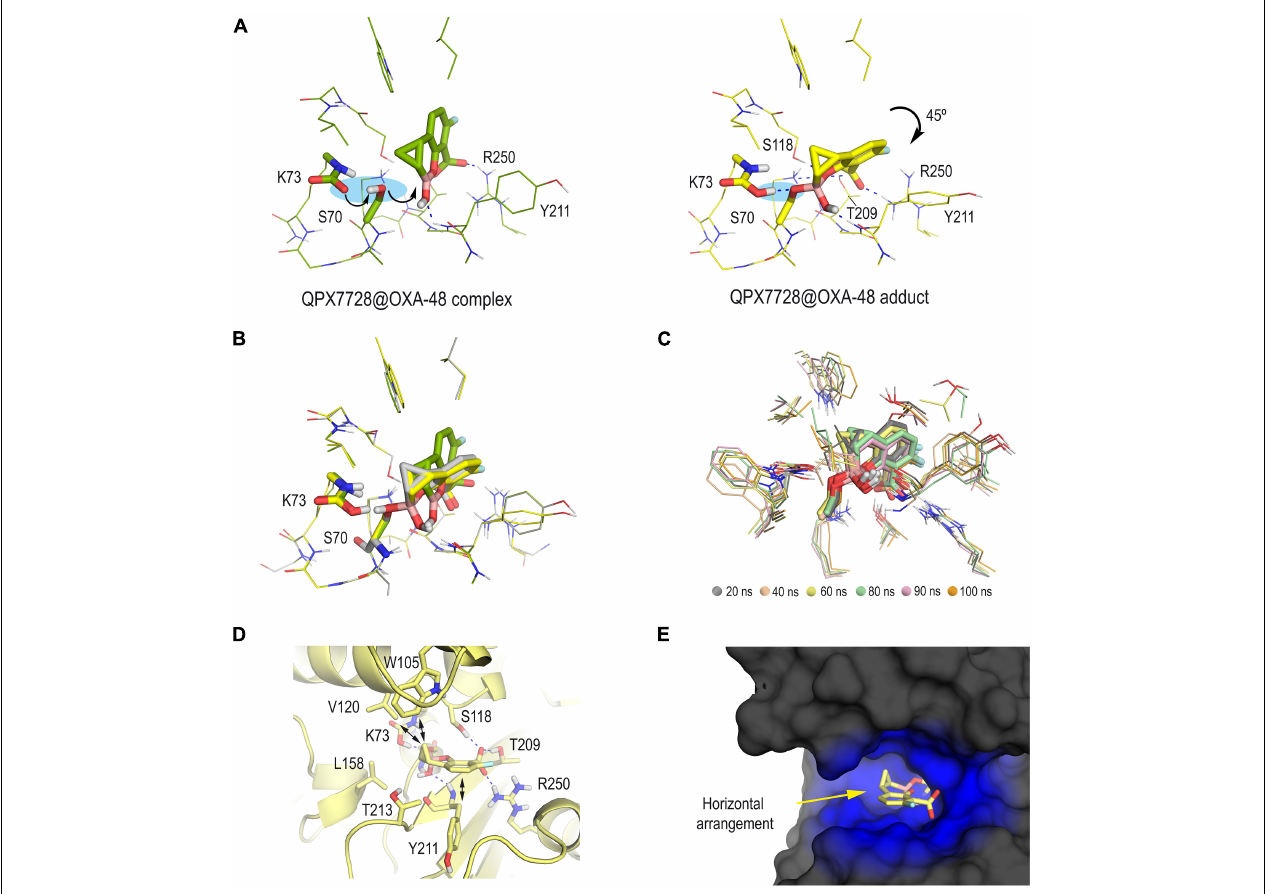
FIGURE 2 | (A) QPX7728@OXA-48 complex (green) and QPX7728@OXA-48 adduct (yellow) obtained by computational studies. Note how the formation of the enzyme adduct would involve the deprotonation of the catalytic serine by the carboxylated residue K73 followed by nucleophilic attack to the boronate group. The bicycle moiety is inclined ∼ 45 ◦ after reaction. (B) Comparison of (A) and PDB ID 6V1O (gray). Note how the QPX7728@OXA-48 adduct (yellow) obtained by computational studies adequately reproduces the arrangement observed in the crystal structure, and therefore the carboxylated residue K73 would be in its protonated form. (C) Superposition of several snapshots from the 100 ns of MD simulation on the QPX7728@OXA-48 adduct. (D,E) Interactions and overall view of the modified QPX7728 in the active site. Note how the horizontal disposition of the modified QPX7728 facilitates CH- π and apolar interactions through both faces of the bicyclic moiety. Relevant side chain residues are shown and labeled. Key hydrogen bonding and electrostatic interactions are shown as blue dashed